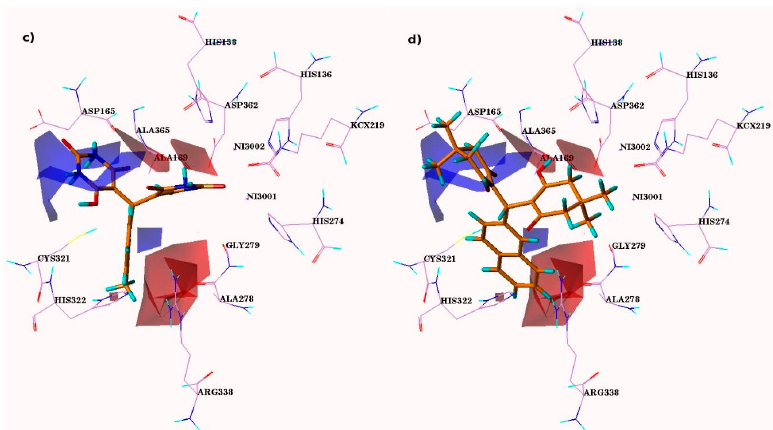
Figure 3. CoMFA steric and electrostatic contour maps. Electronegativity and electropositivity are represented by red and blue contours, while sterically-favored and -disfavored areas are depicted by green and yellow regions, respectively. Panel ( a ) and ( c ) are representative of steric and electrostatic contours of most active comp-4i, while ( b ) and ( d ) are representative of least active comp- 5s , respectively.